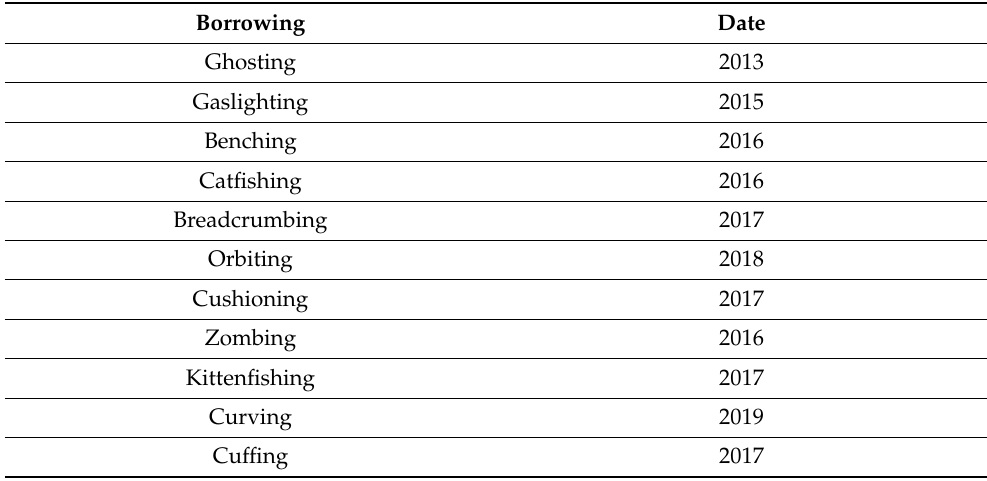
Table 5. Year of first appearance in